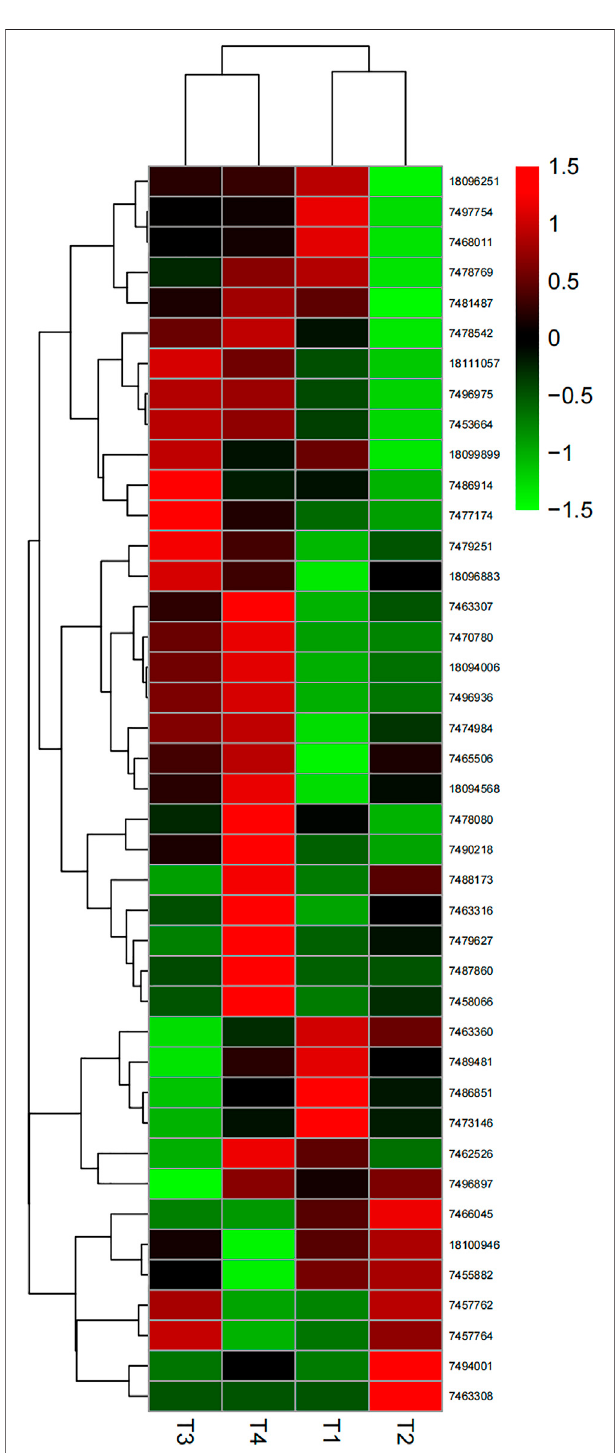
FIGURE 8 | Heatmap of different expression levels in PdpapMFS genes under different treatments by F. oxysporum . Cluster analyses were based on log 2 FPKM. Red boxes represent highly expressed genes. Green boxes represent low expressed genes. The left side represents gene clusters. T1, T2, T3, and T4 indicated that PdPap were infected by F. oxysporum for 6, 12, 24, and 48 h.